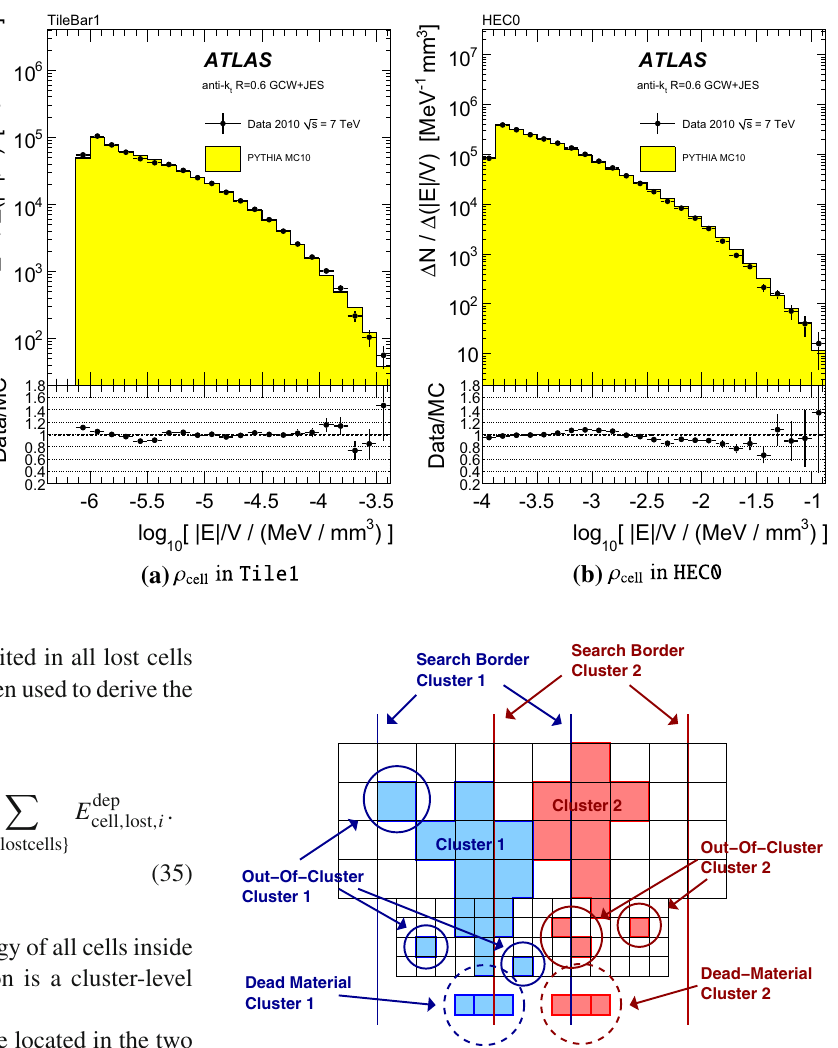
Fig. 15 Illustration of the assignment scheme for cells inside the calorimeter with true signal not captured in a topo-cluster in the context of the out-of-cluster correction (see Sect. 5.4) and for dead material cells outside the calorimeter for the dead material correction discussed in Sect. 5.5. The deposited energy in cells inside the topo-cluster is used to determine the hadronic calibration described in Sect. 5.3. A schematicdepictionofatypicalsectionoftheATLASend-capcalorime- terwithfourhighlygranularelectromagneticsamplingsandfourcoarser hadronic samplings is shown in a view with η as the horizontal and the depth z as the vertical coordinate. The boxes at small z in front of the EM calorimeter symbolise upstream energy losses collected into dead material